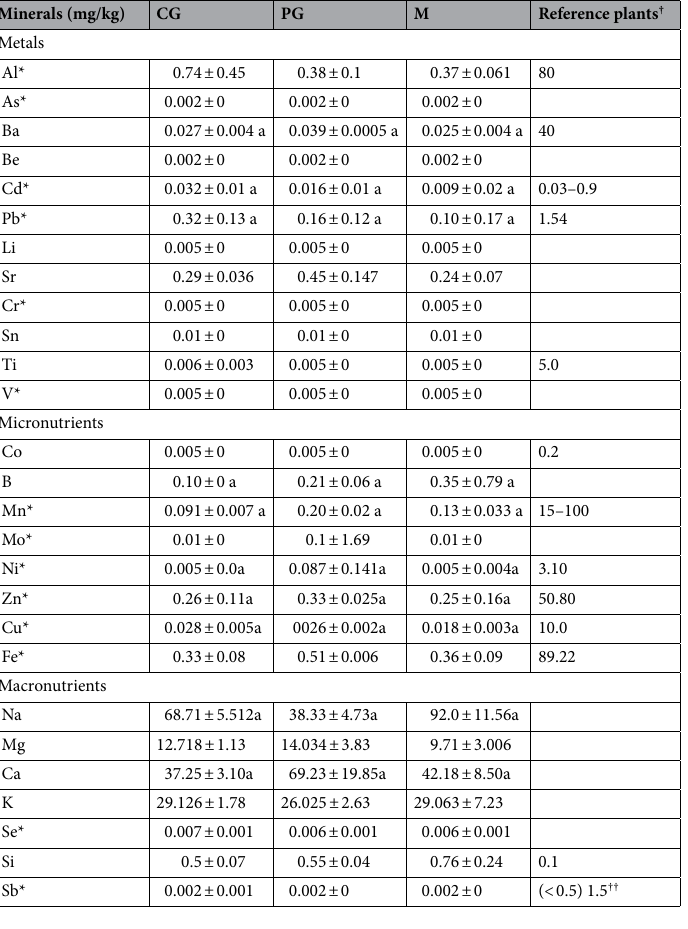
Table 2. ICP-OES analysis of mineral content in leaves (mg/kg) of Laguncularia racemosa collected in Coroa Grande (CG), Pedra de Guaratiba (PG) and Marambaia (M) mangroves, Rio de Janeiro, Brazil. *PTEs. † Markert 18 , values in mg/Kg dry weight. †† Levels in leaves of different plants: Pérez-Sirvent et al. 19 Equal lowercase letters in the same row indicate no significant difference ( P adj > 0.05). Unaccompanied elements of these letters were not statistically compared among sites.